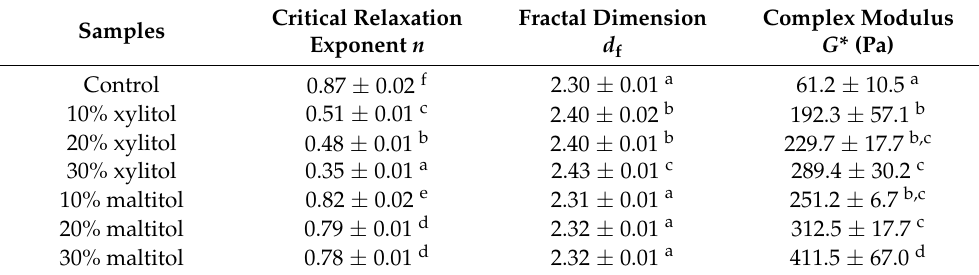
Table 1. Dependence of the critical relaxation exponent n , fractal dimension d f , and complex modulus at 1 rad/s for κ -carrageenan gel with different xylitol and maltitol concentrations.